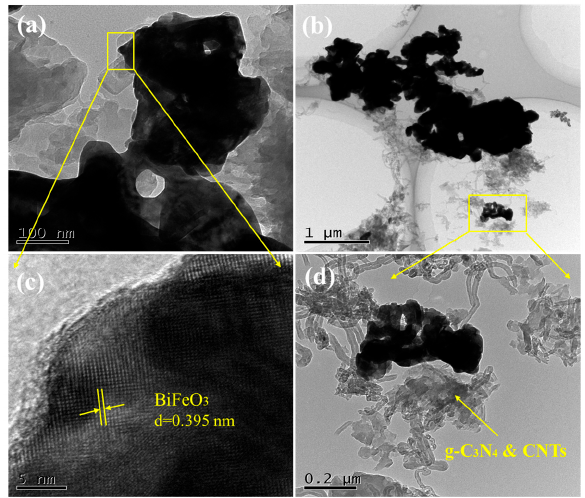
Figure 2. TEM images of ( a , c ) CNB, ( b , d ) CNBT.